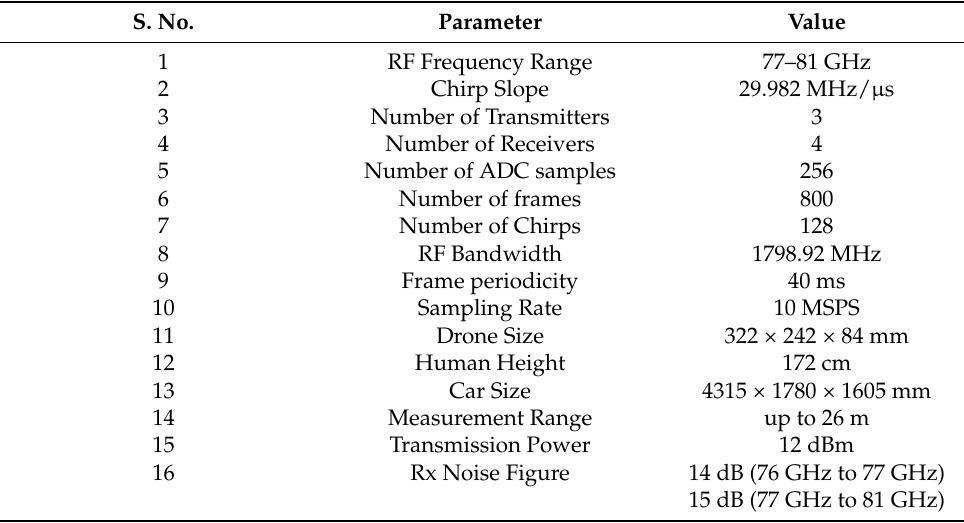
Figure 1. The mmWave radar front-end architecture. Table 1. Configuration parameters for mmWave radar